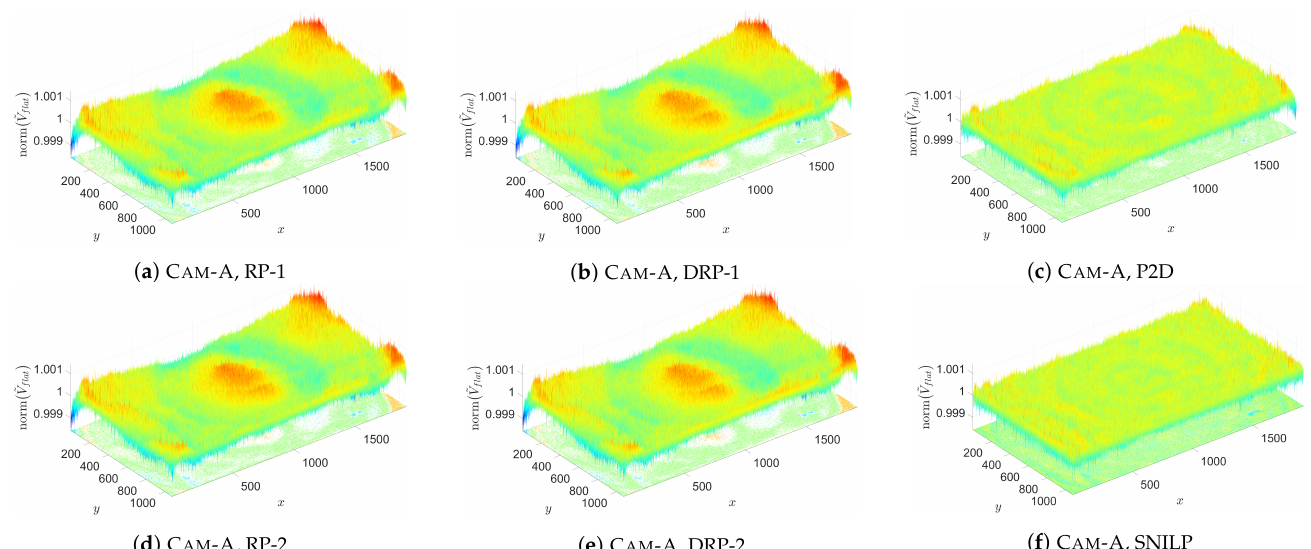
Figure A2. Comparison of vignetting corrections of flat-field image I V for C AM